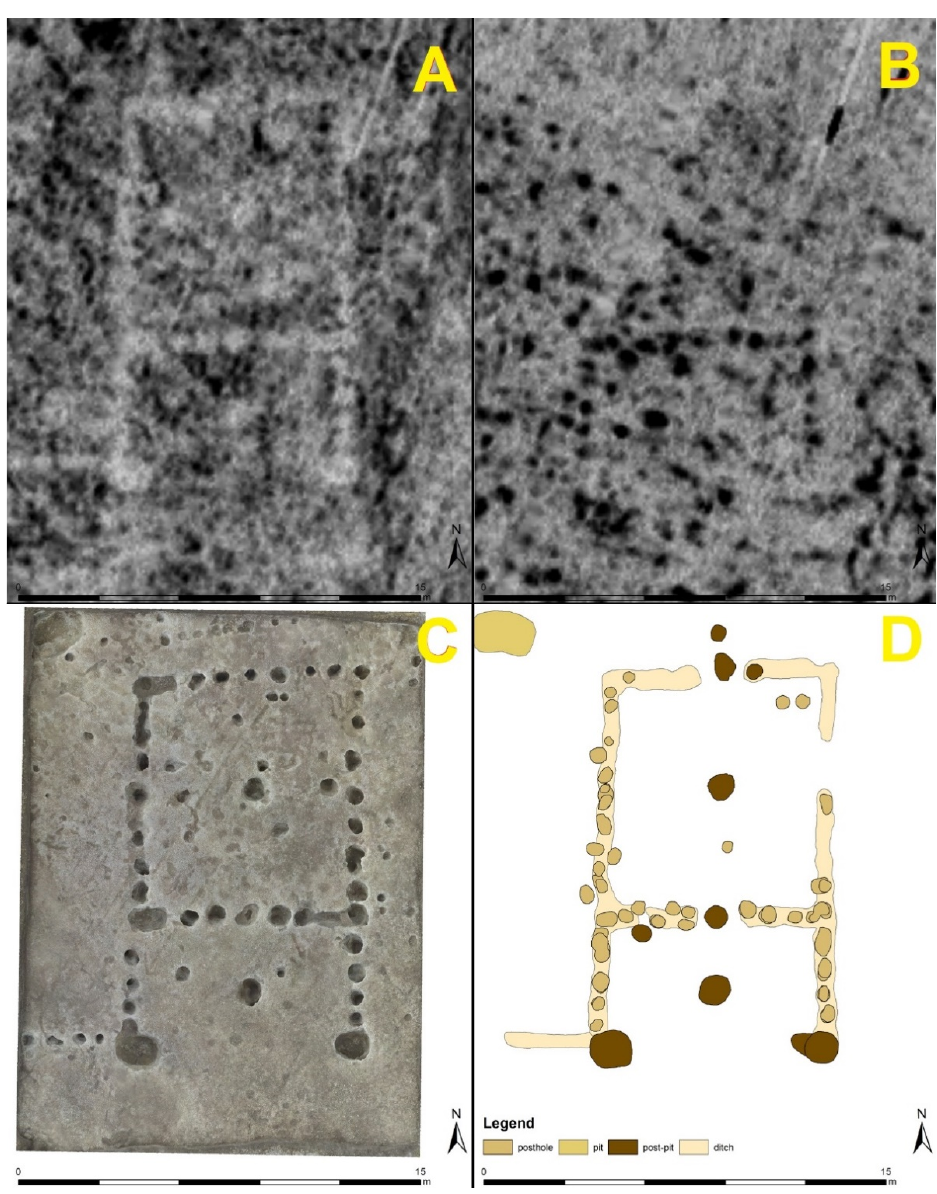
Figure 12. Comparison of GPR datasets for the area of trench 1 (( A ) depth range 60–100 cm, ( B ) depth range 140–170 cm), showing the different responses of the postholes. ( C ) The orthophoto generated by IBM during the excavation, and ( D ) archaeological interpretation of the GPR data before